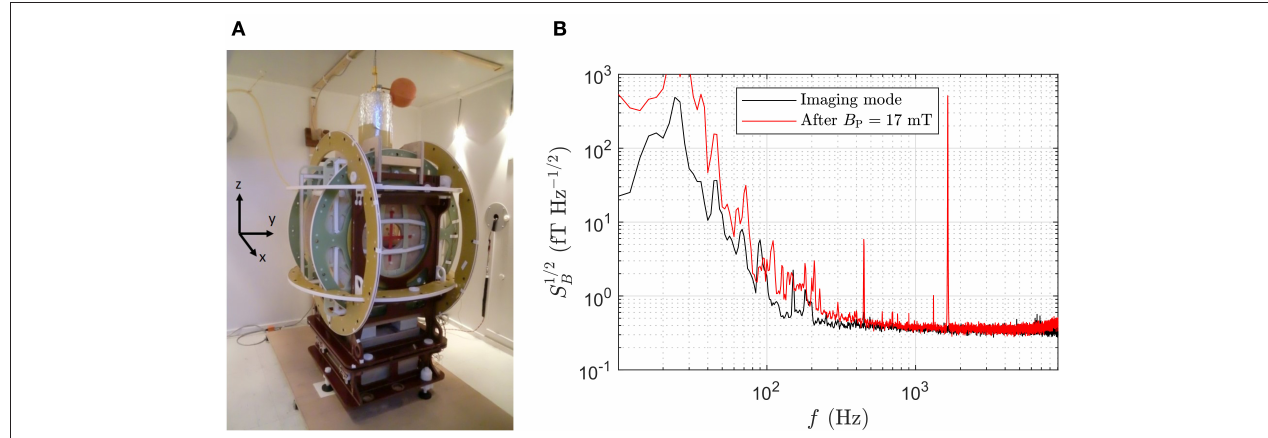
FIGURE 1 | (A) ULF-MRI setup inside magnetically shielded room. (B) Field noise (referred to the bottom pick-up loop) of the 3D ULF-MRI setup in imaging mode and after a polarizing pulse of B P = 17 mT. The signal at 1,645 Hz was obtained with B 0 = 38.6 µ T and dB x / dx = 2.4 µ T/m. Data were captured 25 ms after initiating B P turn-off (compare to validation measurement shown in Figure 4